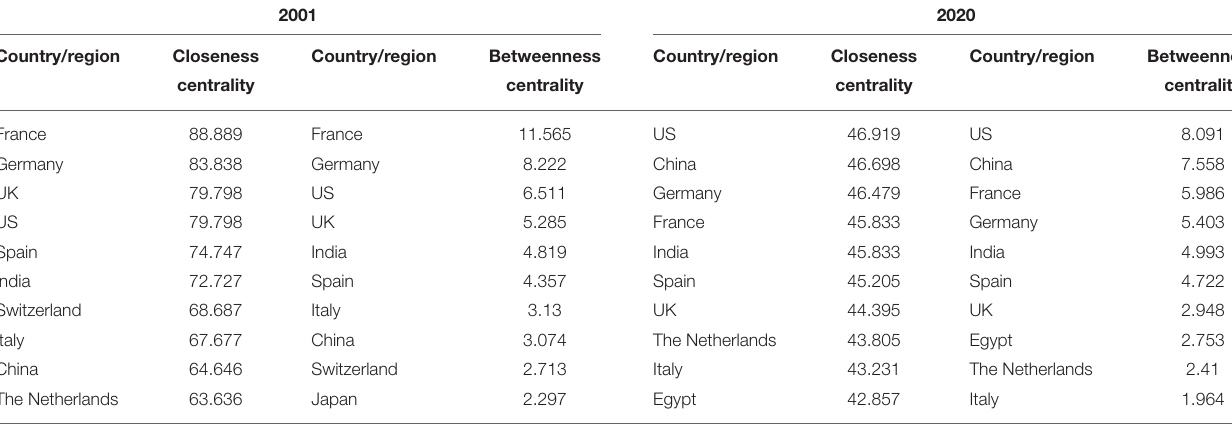
TABLE 2 | Top 10 countries by closeness centrality and betweenness centrality in 2001 and 2020.